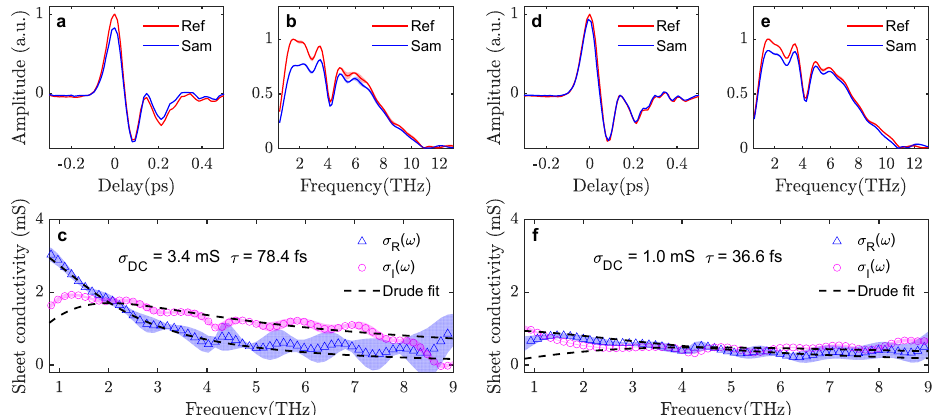
Figure 3. ( a,b ) Transmitted waveforms and spectra through bare PET (Ref) or through graphene/PET (Sam) with an incident THz field strength of 60 kV/cm. Light red and blue bands indicate the experimental standard deviation between scans. ( c ) Extracted complex-valued conductance spectrum of the graphene under low THz field strength (together with the Drude model fitting curves). Light blue and magenta bands indicate the standard deviation of the calculated conductance. ( d,e ) Trans- mission waveforms and spectra (Ref and Sam) with an incident THz field strength of 1050 kV/cm. ( f ) Extracted and fitted conductance spectra at strong THz field